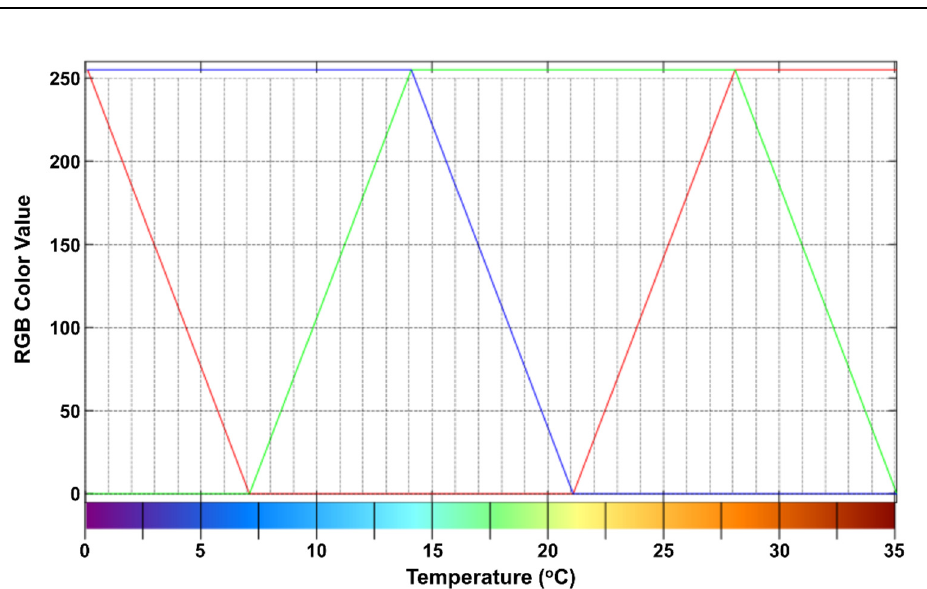
Figure 6. Matching graph that maps the RGB color values to the corresponding temperature values to convert the original ocean satellite image into the temperature value matr ix.